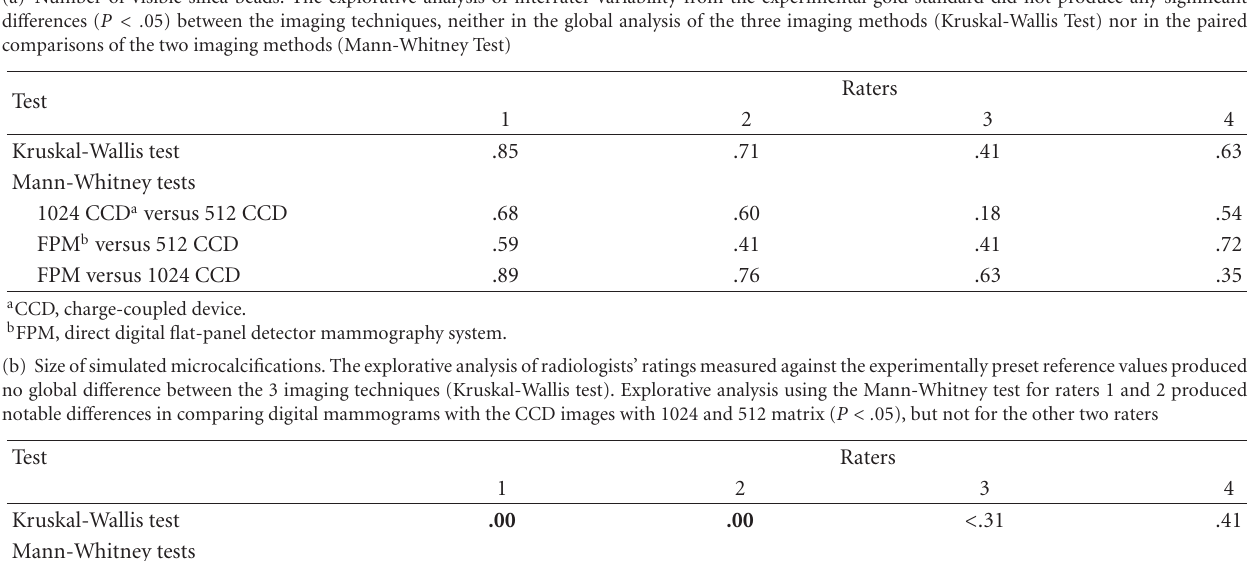
Table 2: Explorative analysis using the Kruskal-Wallis and Mann-Whitney tests. The P values were not corrected for multiple test scenarios. P values < .05 are labeled in bold typeface. (a) Number of visible silica beads. The explorative analysis of interrater variability from the experimental gold standard did not produce any significant di ff erences ( P < . 05) between the imaging techniques, neither in the global analysis of the three imaging methods (Kruskal-Wallis Test) nor in the